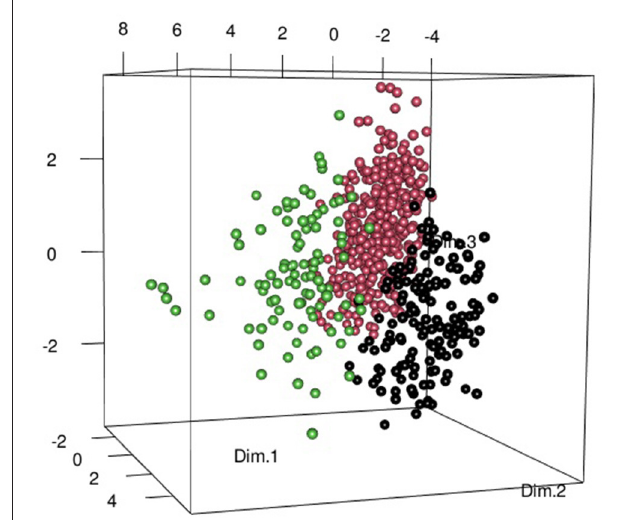
FIGURE 1 | Three-dimensional (3D) scatter plot composed of the first 3 dimensions of the principal component analysis, identified as providing greatest inertia gain on hierarchical clustering. The Somatic Group (SG) is represented by the black points. Patients in the Dryness without autoimmune features (DAF neg ) group are represented by pink points and Dryness with autoimmune features (DAF pos ) patients with green dots. This Figure was produced using the scatterplot3d and rgl